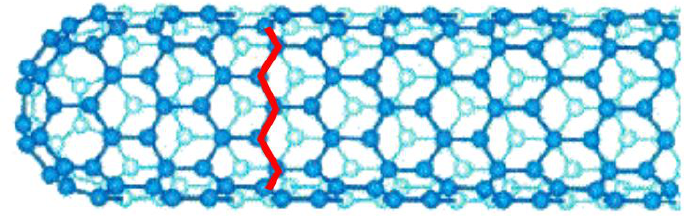
Figure 11. m = 0 (chiral angle = 0 ◦ tubes are called “zigzag”). Adapted from Weisman, 2004, p. 24.